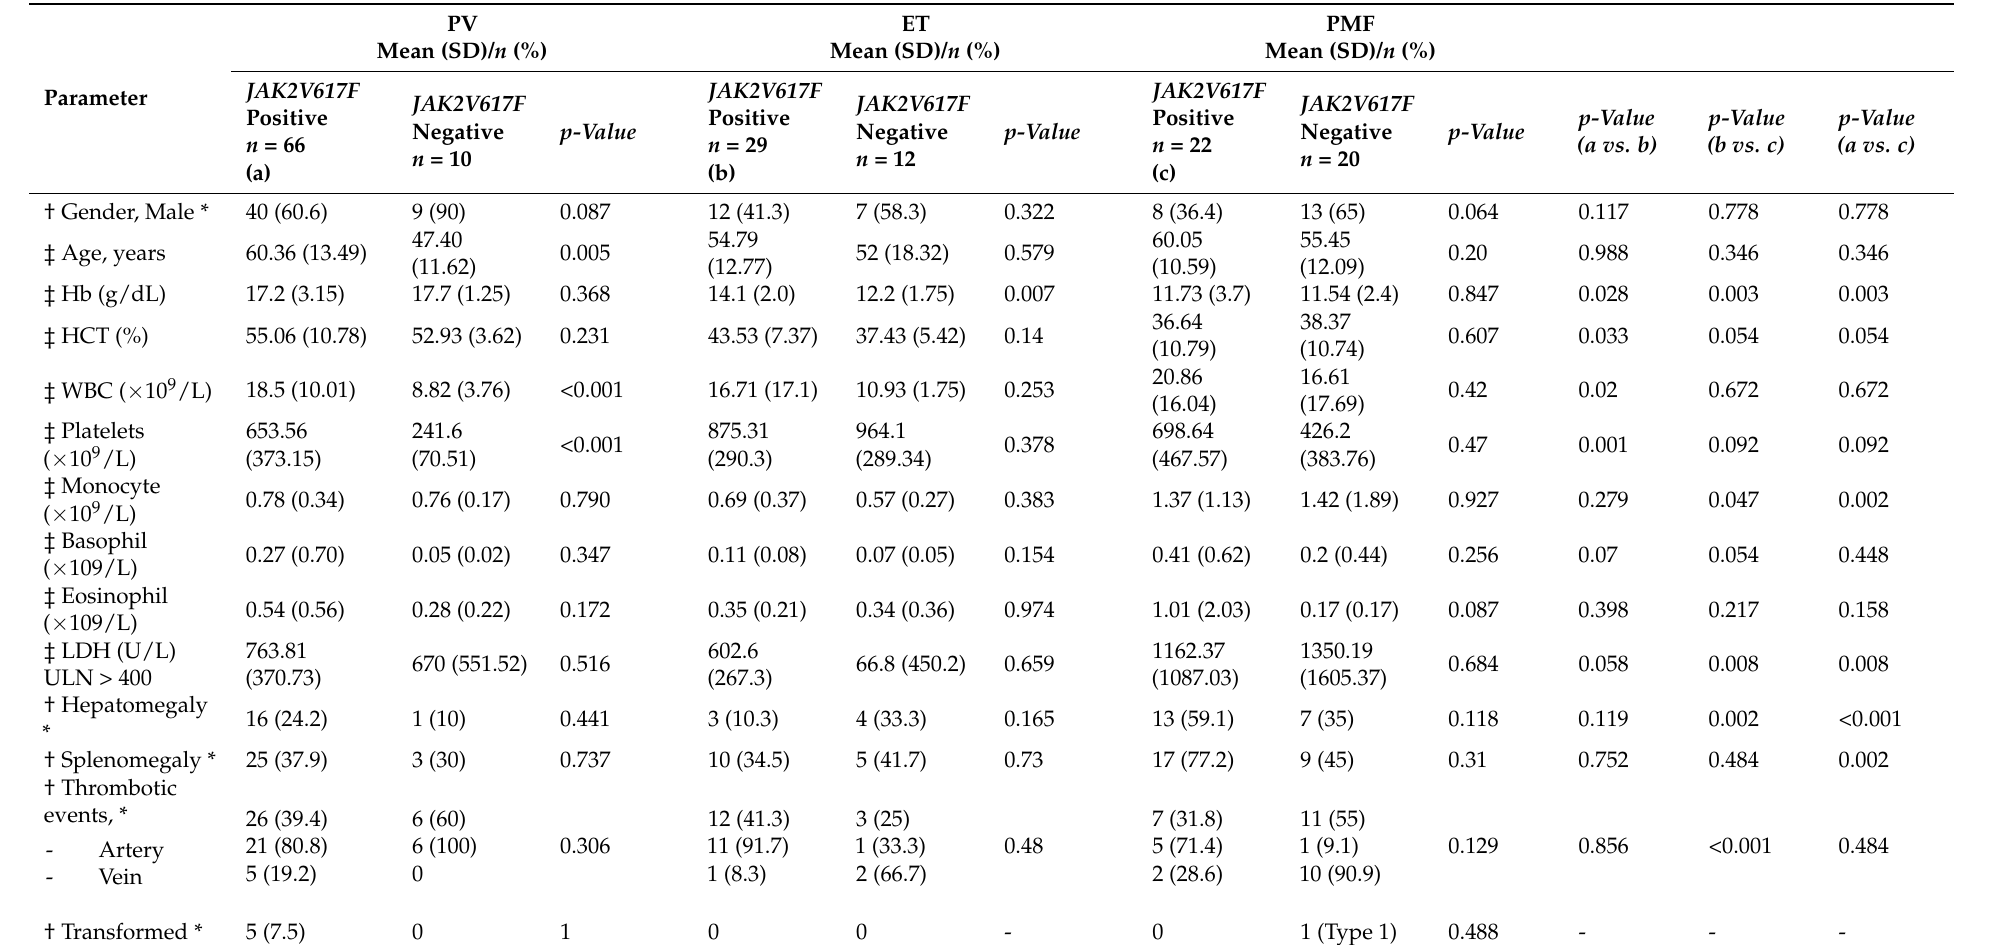
Table 3. Clinicohematological parameters of JAK2 V617F positive and negative cases according to MPN